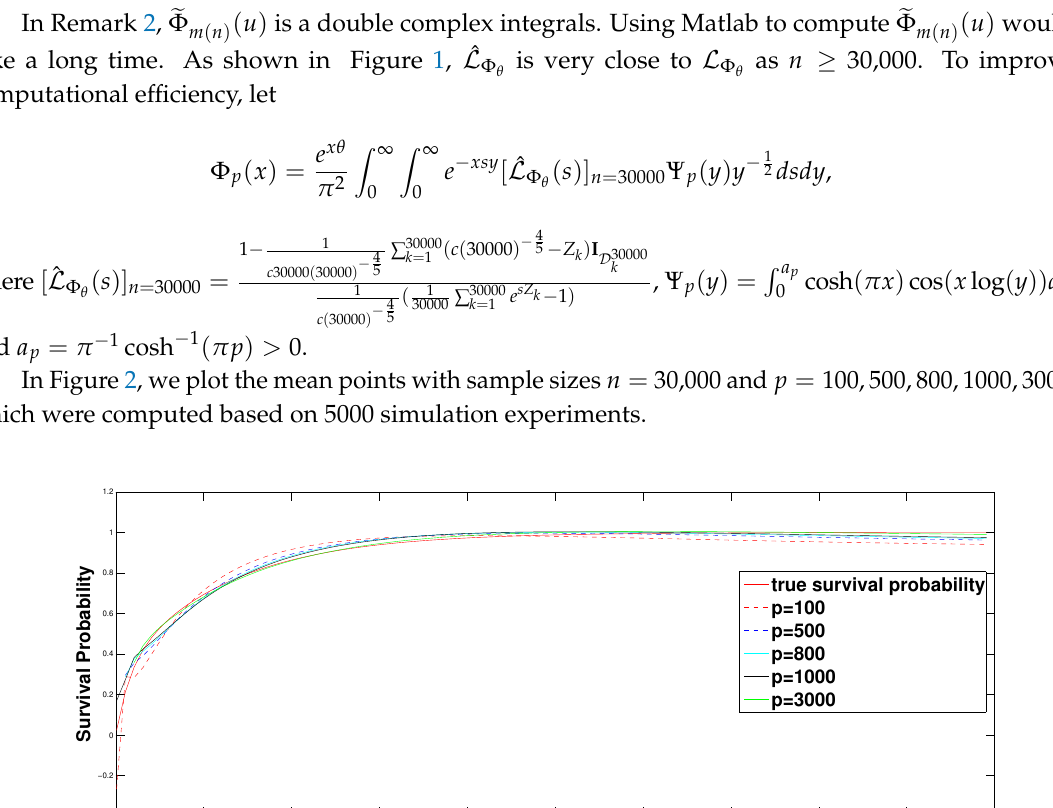
with sample sizes n = 5000, 10,000, 30,000, 50,000, 80,000. θ